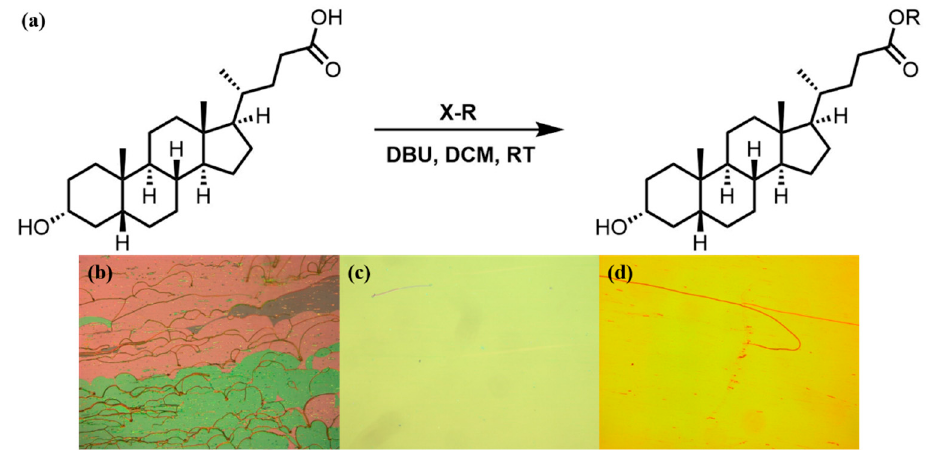
Figure 5. ( a ) Synthetic modification of LA using alkyl halides, ( b ) POM image of 5 wt. % LA in E7, ( c ) 5 wt. % LA-Bn in E7, and ( d ) 5 wt. % LA-Me in E7.